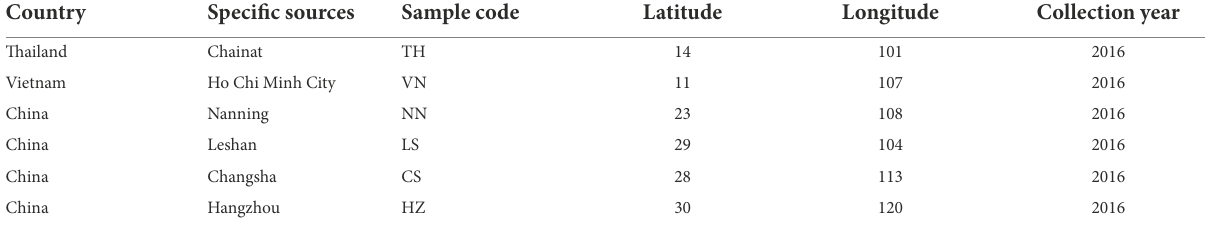
TABLE 1 Collection and sequencing of Cnaphalocrocis medinalis samples.